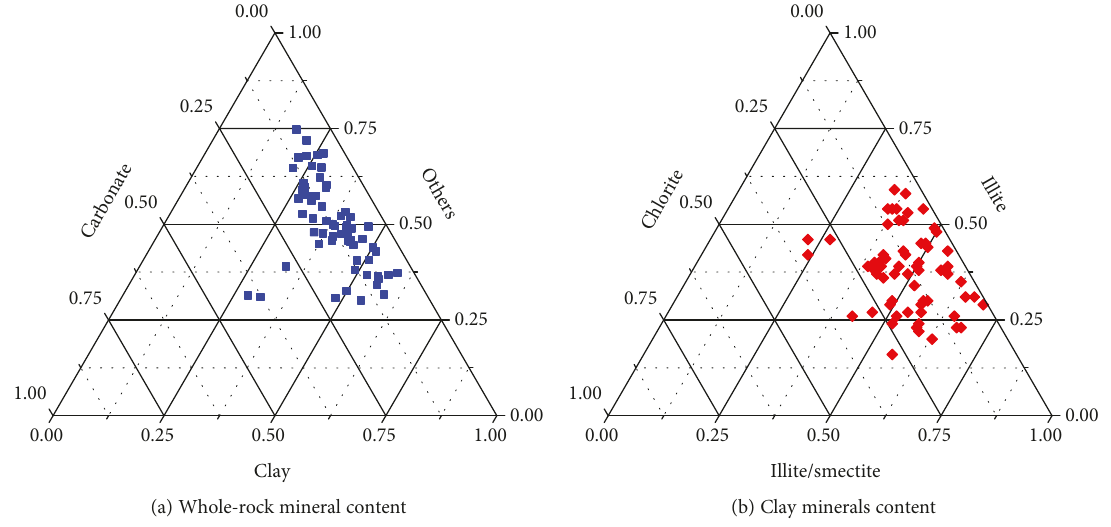
Figure 8: The characteristics of reservoir shale mineral composition.